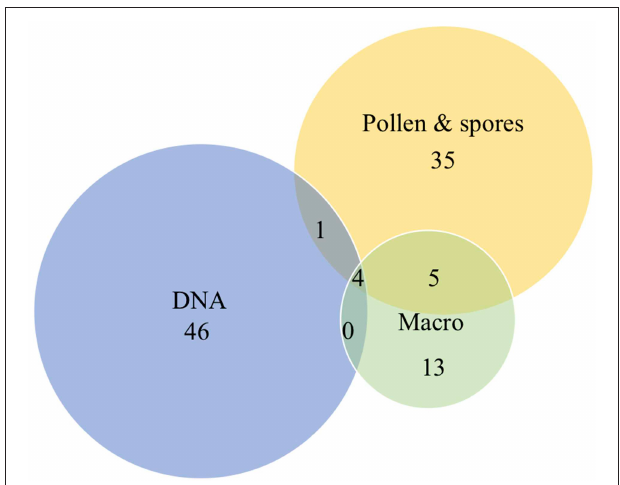
FIGURE 4 | Venn diagram showing the number of plant taxa detected from Hässeldala Port’s sediments using micro- and macrofossil and eDNA analyses. See Figure 3 for details on